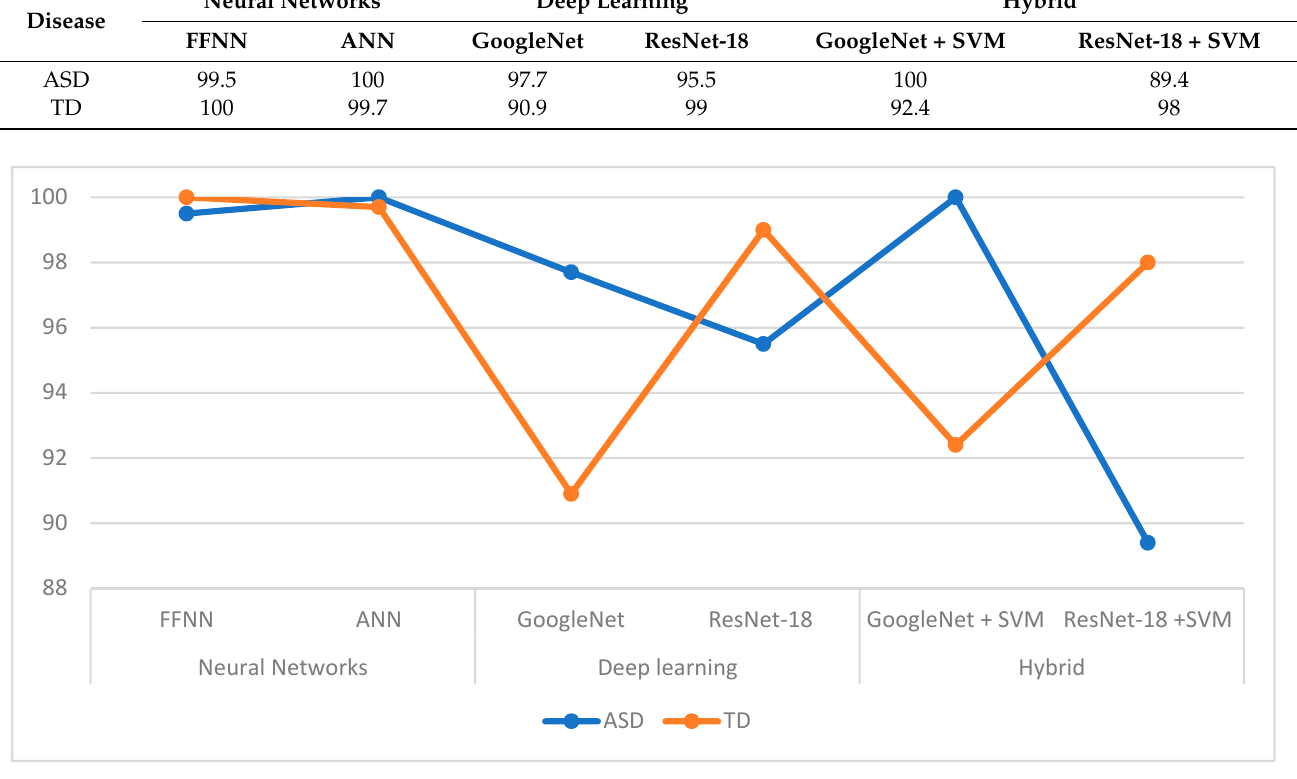
Figure 21. Evaluation of the performance of the proposed systems for diagnosing autism at the level of each disease. Table 9. Accuracy reached by proposed system in the diagnosis of each class.